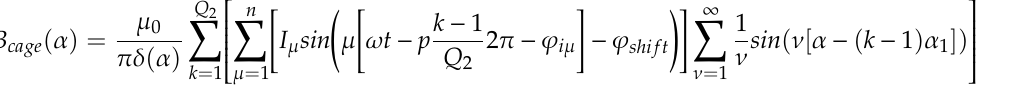
Figure 6. ( a ) Comparison between no-load and loaded operational state; field distribution ( b ) from FEA, frequency spectrum (right).